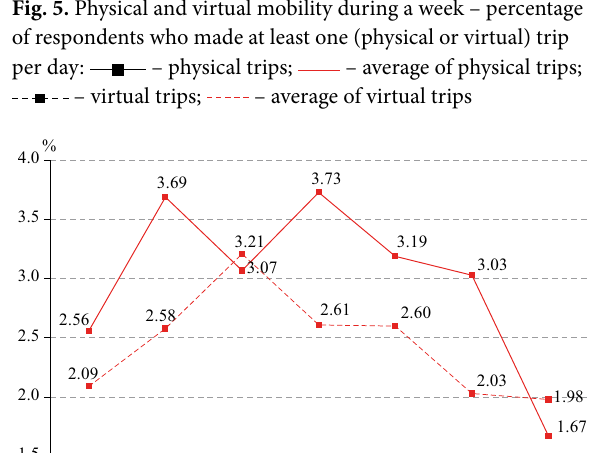
Fig. 6. Physical and virtual mobility during a week – average of physical ( ) and virtual ( ) trips per